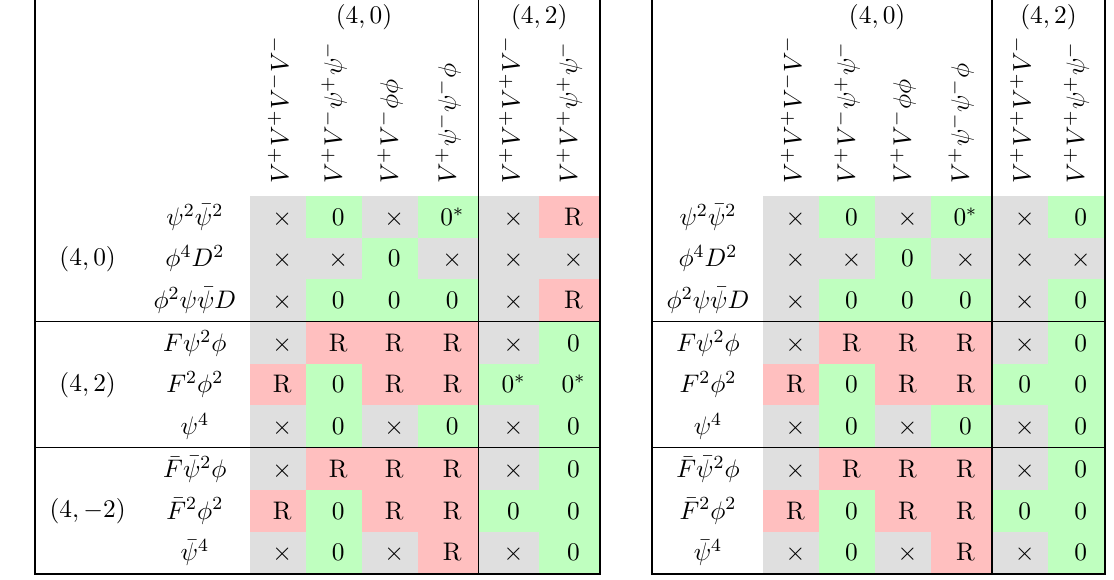
Table 2 . One-loop contributions of various dimension 6 operators to certain helicity amplitudes. The upper left and right quadrants correspond to contributions of tree-level dimension 6 operators to j h j = 0 and select j h j = 2 amplitudes, respectively; the lower left and right quadrants correspond to contributions of loop-level or exceptional dimension 6 operators to j h j = 0 and select j h j = 2 amplitudes. Here (cid:2) means there’s no diagram, 0 a vanishing contribution, and R a non-vanishing rational